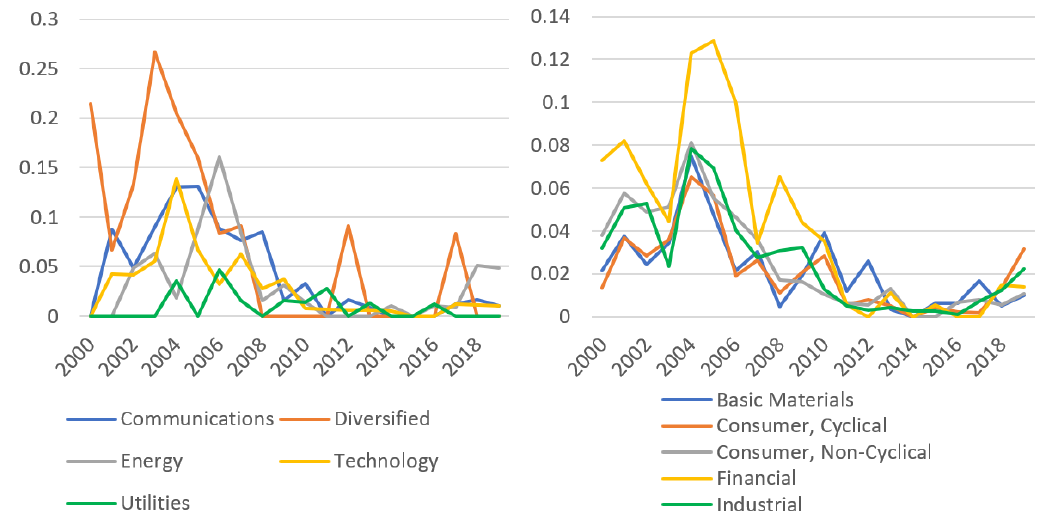
Figure 2. The frequency of all industry defaults per year. Source: NUS-CRI database.